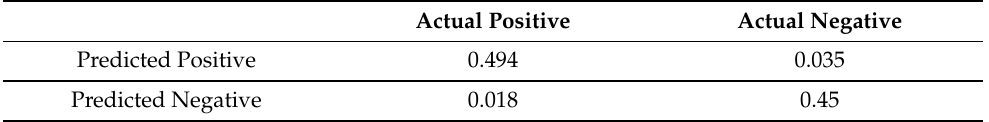
Table 9. Confusion matrix of Naive Bayes classifier.